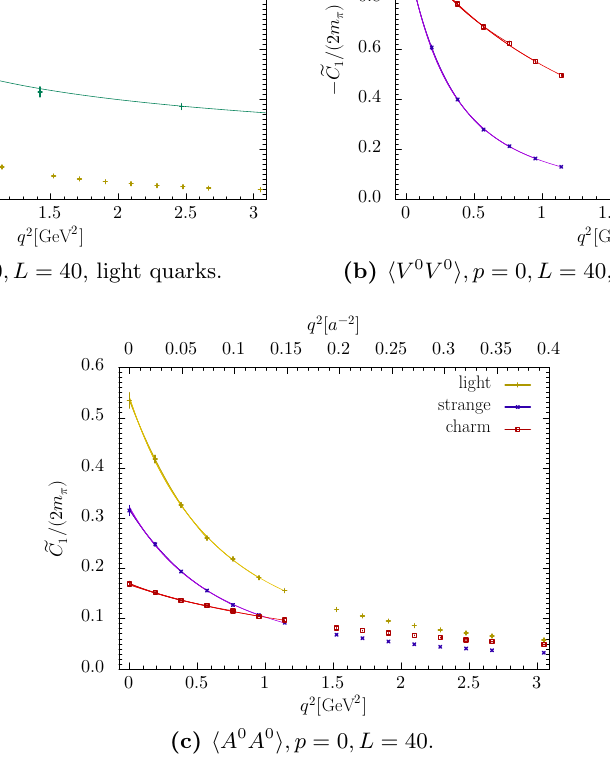
Figure 18. The Fourier transform e C 1 at low values of q 2 . The curves (without error bands) show the series of (cid:12)ts discussed in the text. In panel (a) the results for FT light", whereas the points and curve labelled by \3pt light" show the r.h.s. of (5.17) evaluated with our data for the vector form factor F V and (cid:12)t 1 of table 4.